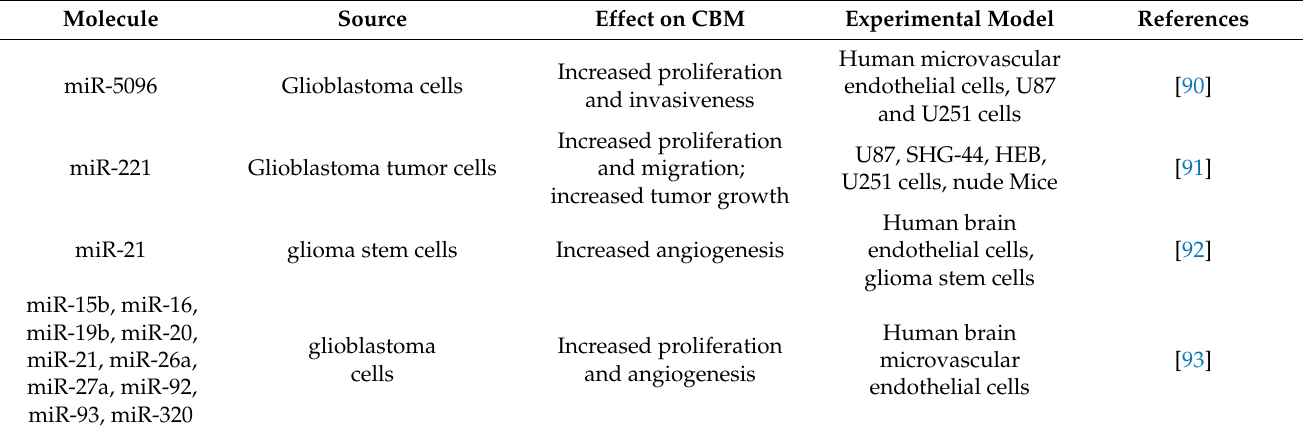
Table 2. Angiogenic microRNAs in EVs with a role in